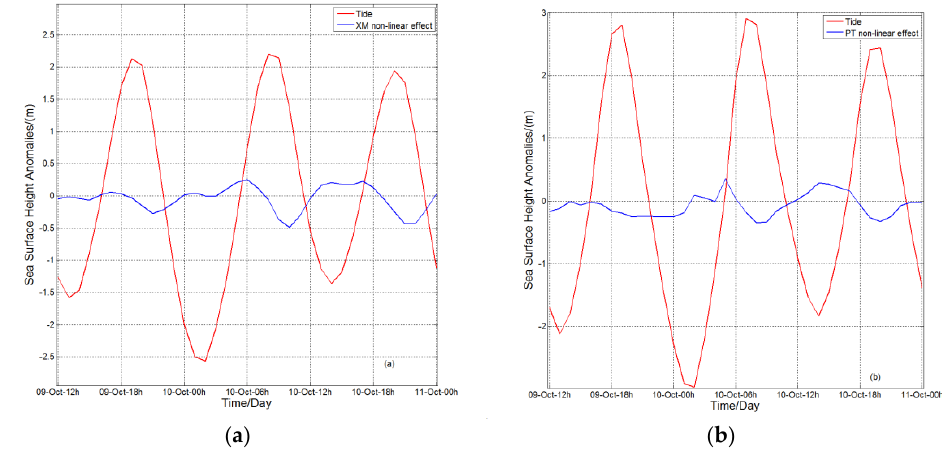
Figure 9. Sea surface height anomalies due to the tide-surge nonlinear interactions and tidal height at ( a ) XM and ( b ) PT. The model is forced by both the tide and the NCEP wind modified by 1.3-times. 4.2. Storm Surge as a Coastally-Trapped Kelvin Wave The de-tided model sea level anomalies from 03:00 to 08:00 on 10 October 1994 (Figure 10) indicate a storm surge generated along the coast of Fujian, when the typhoon was located northeast of Taiwan. They also showed a southwestward propagation of storm surge. The sea level anomalies were relatively high near the Pingtan tide-gauge station at 03:00 on 10 October (Figure 10a). The high sea level anomalies propagated southwestward, arriving at the Xiamen tide-gauge station at 06:00 (Figure 10d) and at the Dongshan tide-gauge station 2 h later.